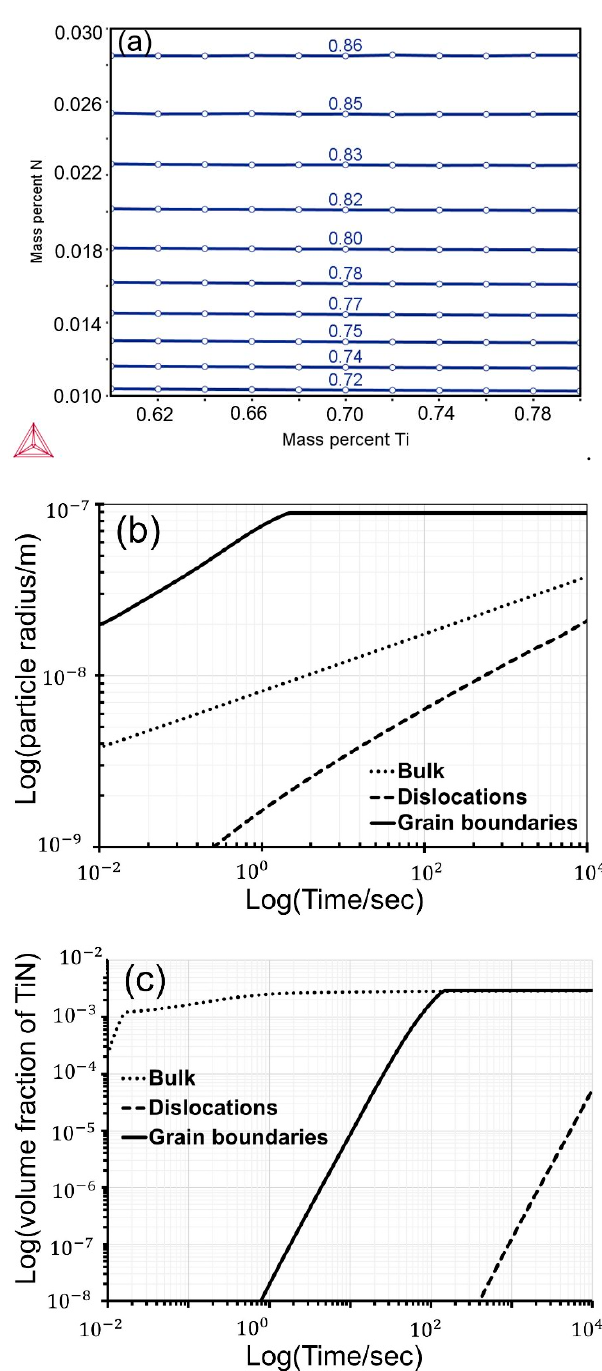
Figure 4. ( a ) A contour plot showing the calculation results comparing the titanium content to that of nitrogen, ( b ) the calculated mean particle radius and ( c ) volume fraction of the observed Ti(N,C) from Thermo-Calc Prisma at a temperature of 950 °C for the time periods up to 10 4